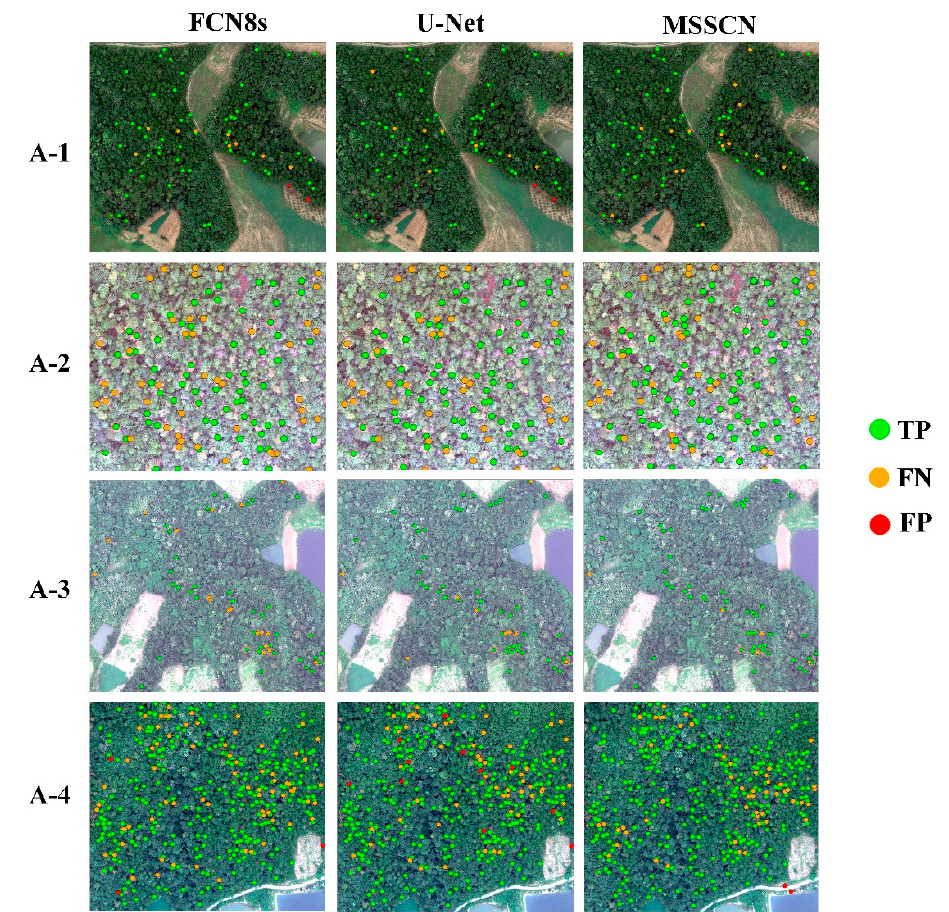
Figure 8. Location results of different approaches in test sites (A-1, A-2, A-3, A-4). TP (true positive) is the number of correctly detected trees, FN (false negative) is the number of trees that were not detected (omission error), and FP (false positive) is the number of extra trees that did not exist in the field (commission error).